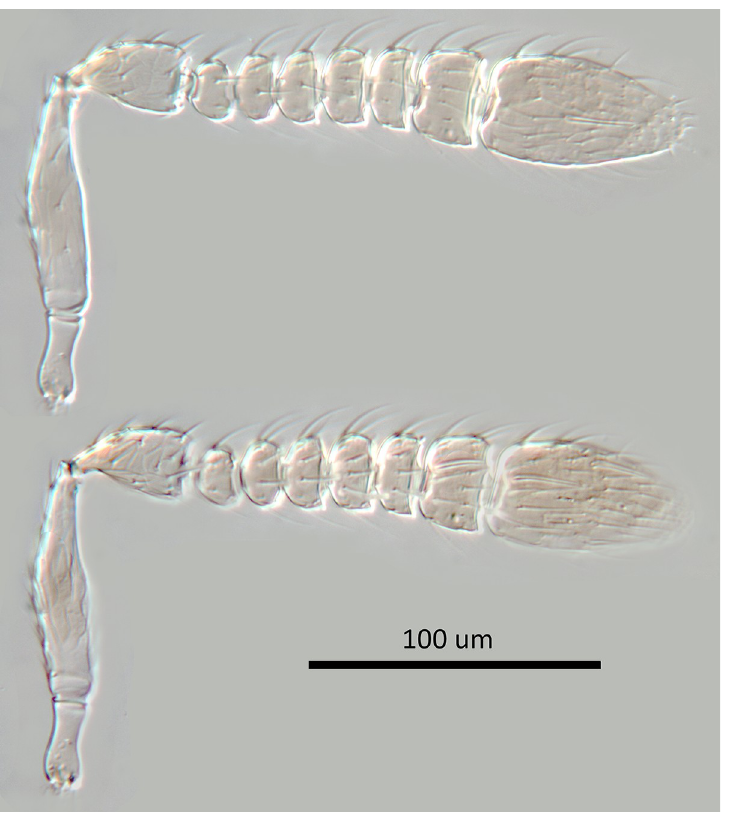
Fig 12. M . macadamiae male antenna, inner and outer aspects.